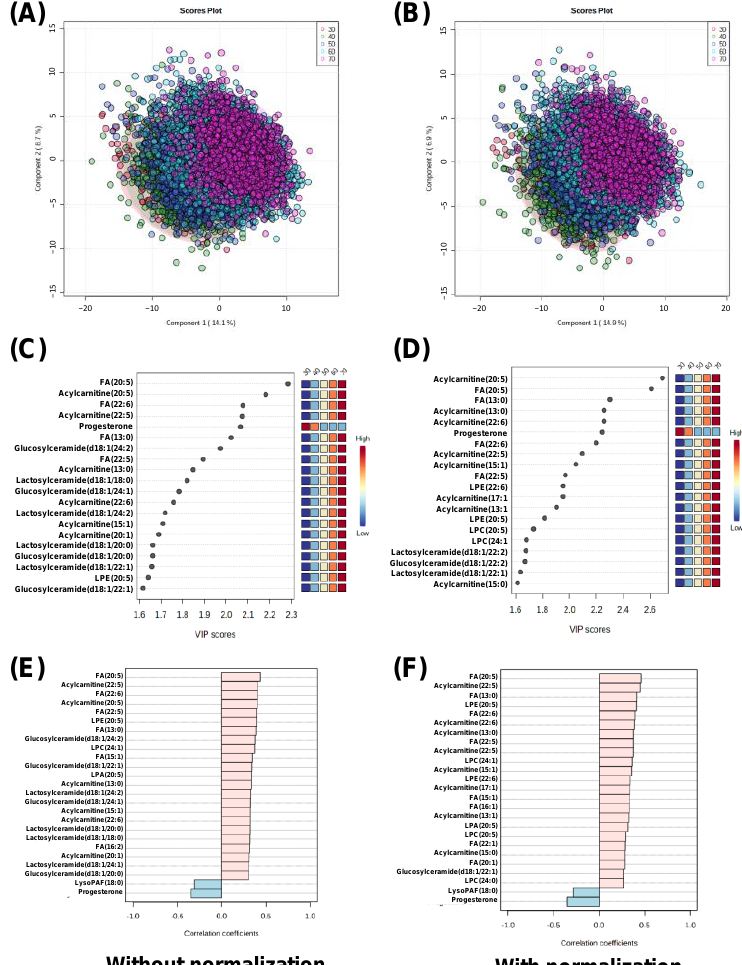
Figure 6. The relationship between ages and metabolomic profile using PLS-DA and PatternHunter. ( A , B ) Score plots. ( C , D ) VIP scores. ( E , F ) Correlations produced using PatternHunter. ( A , C , E ) Ana- lytical results using the data without normalization and ( B , D , E ) analytical results using the data with normalization.